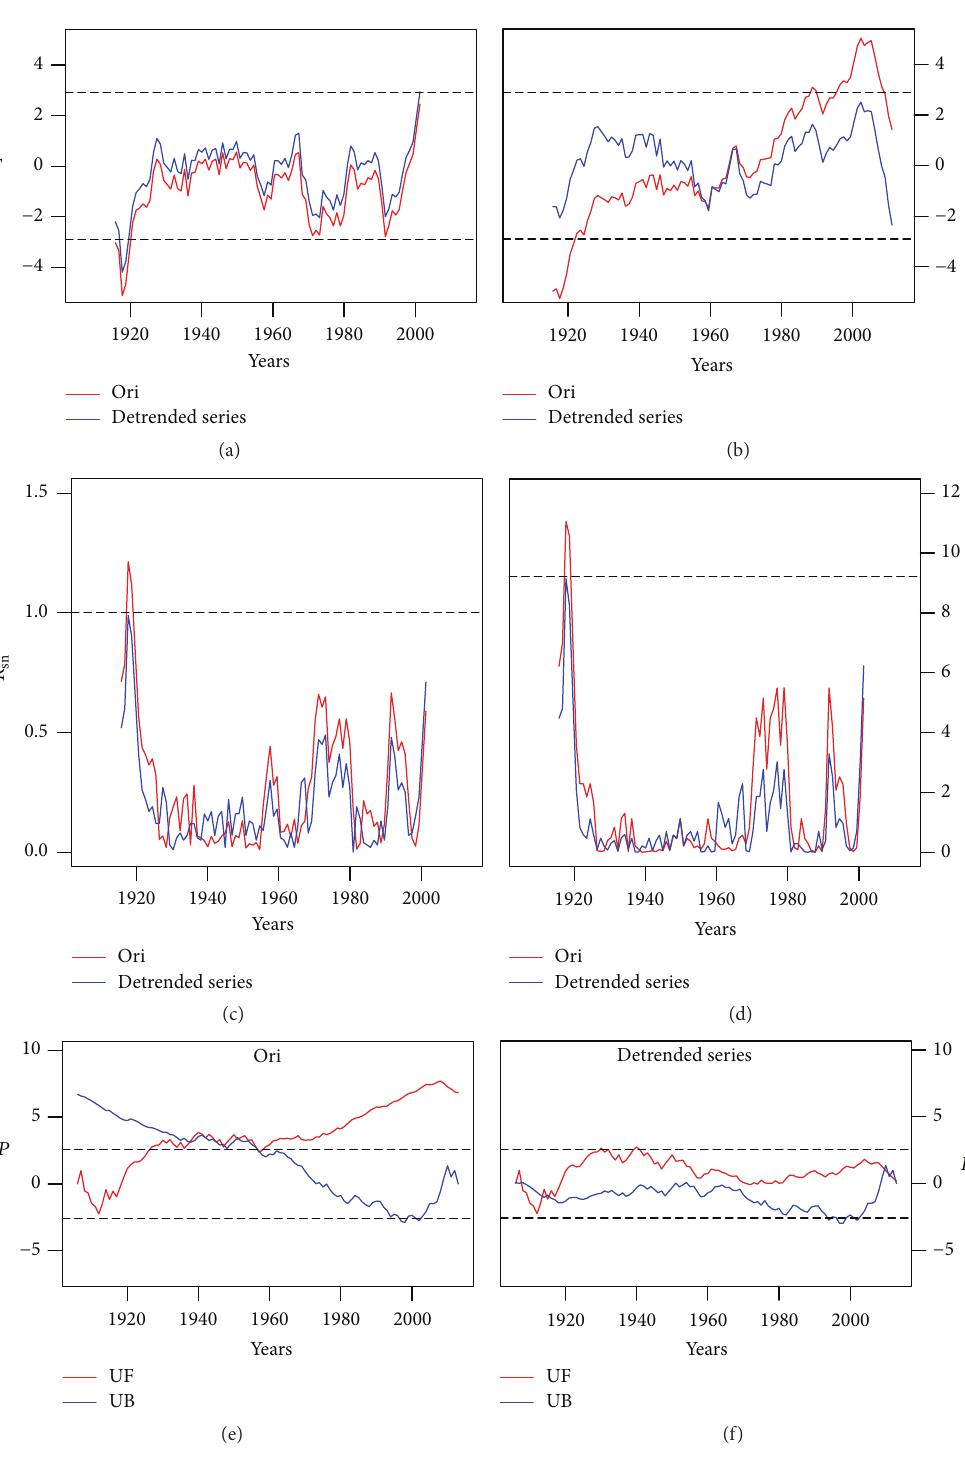
Figure 7: Effects of detrending on abrupt changes detected by five methods: (a) MTT, (b) CRA, (c) YAMA, (d) LP, (e) MK for the original series, and (f) MK for the detrended